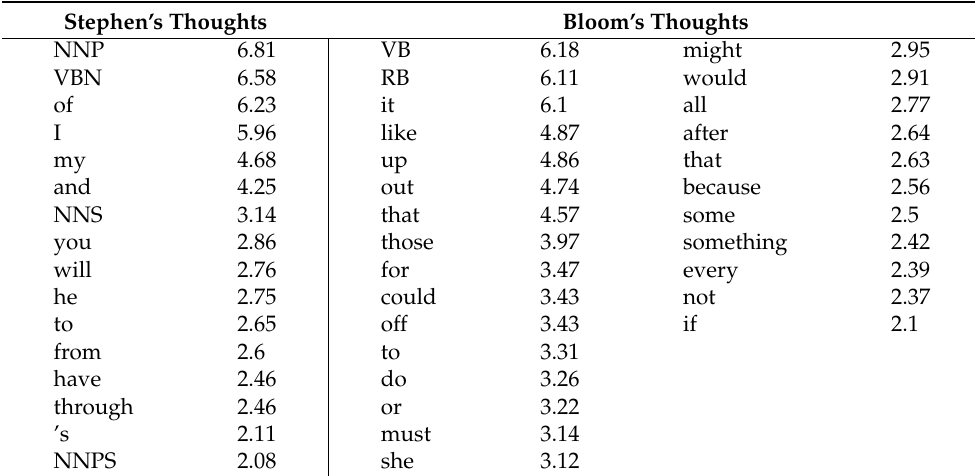
Table 4. Adjusted Pearson residuals for Stephen’s and Bloom’s